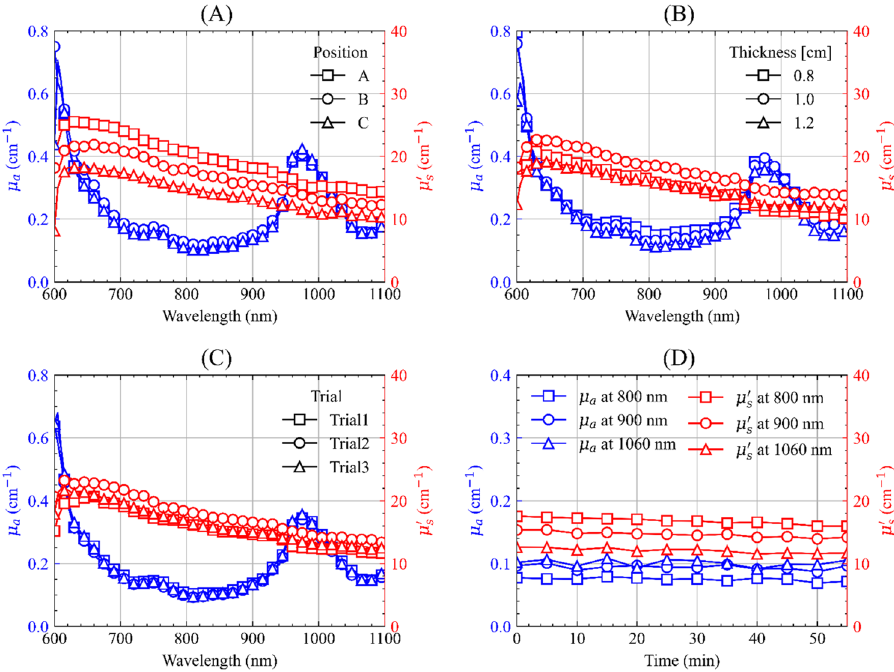
Figure 1. Influence of different types of measurement conditions on the optical properties of fresh porcine pancreatic tissues: ( A ) intra-sample variation, ( B ) sample compression, ( C ) sample repositioning, ( D ) stability in the recovered optical properties over 1 h at 800, 900 and 1060 nm. Each subplot represents the results attained in a single organ.